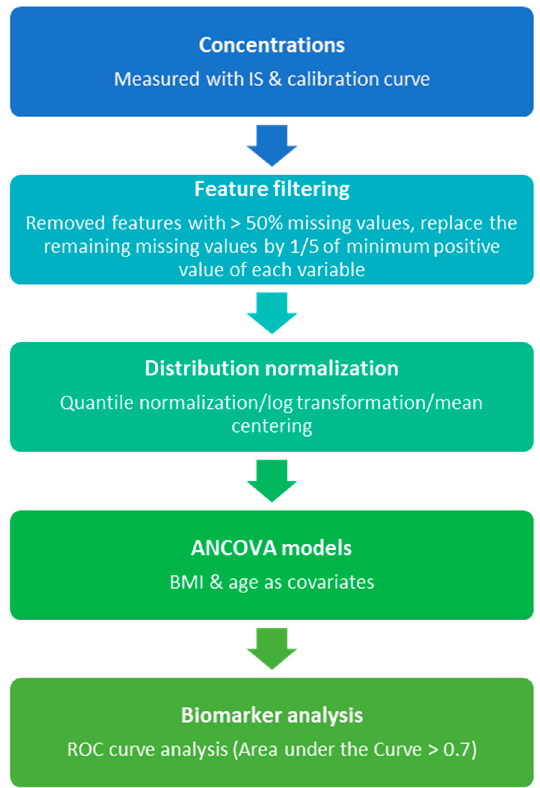
Figure 1. Metabolomics analysis workflow.